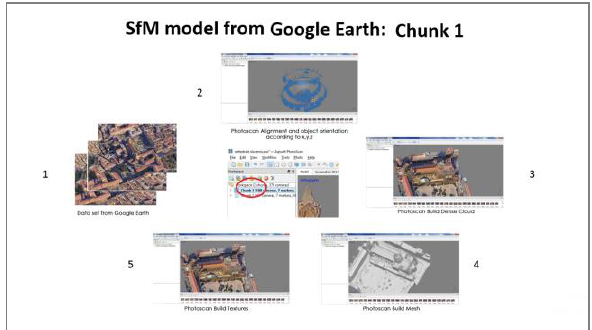
Figure 6. SfM process for GE model: chunk 1